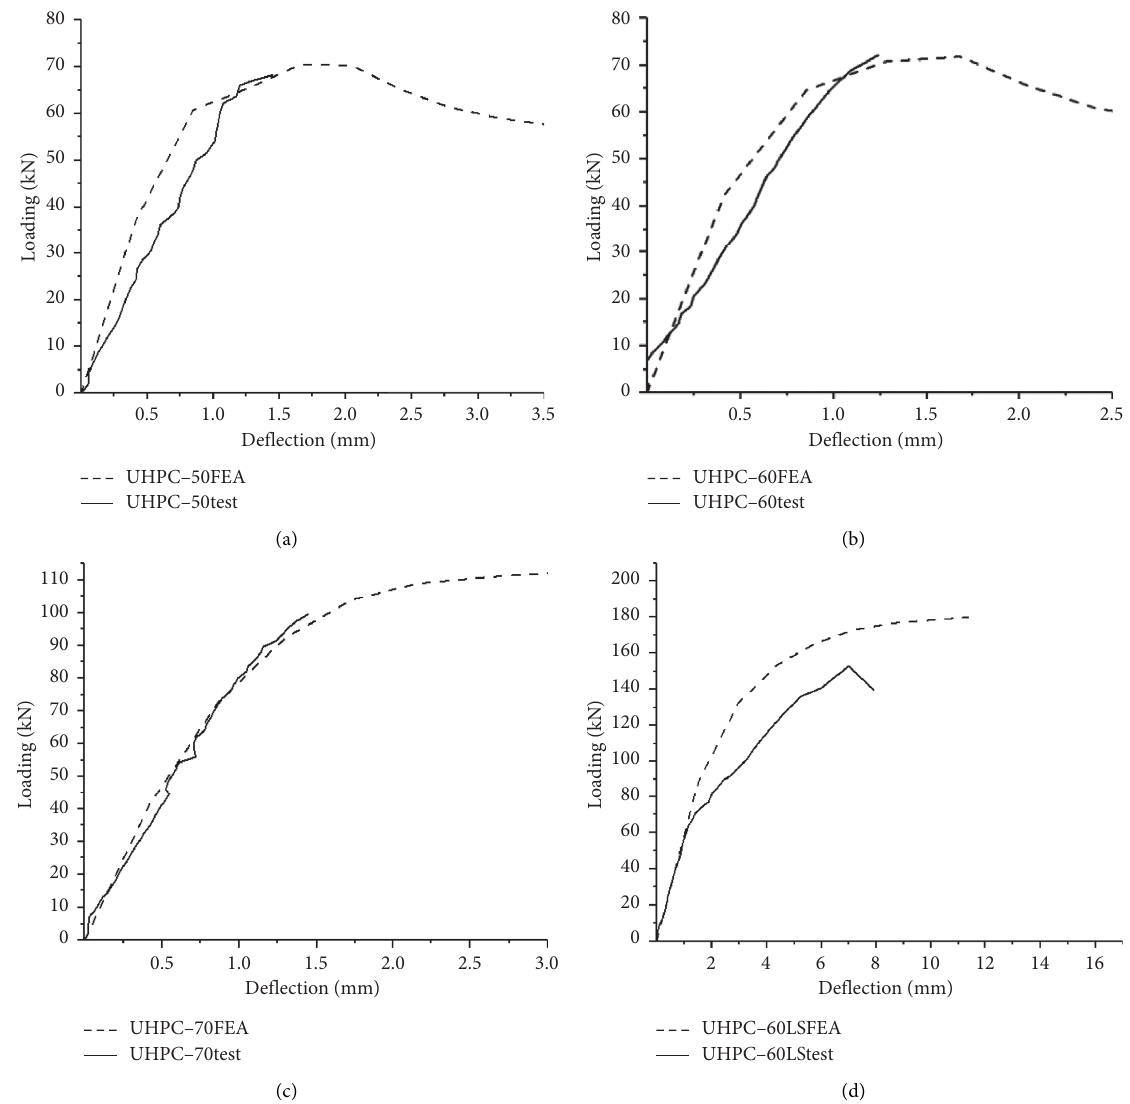
Figure 25: Experimental and numerical comparisons of loading-deflection curves. (a) Specimen U50. (b) Specimen U60. (c) Specimen U70. (d) Specimen